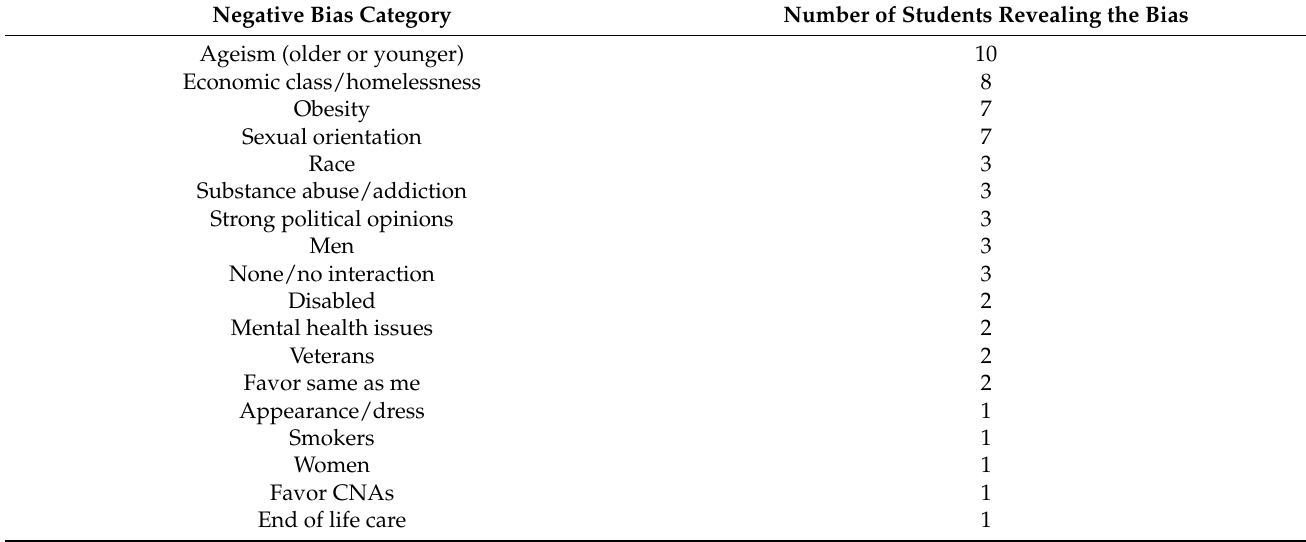
Table 2. Categories of student biases revealed by the question “Of what biases did you become aware during encounters with people/venues in your service-learning project?” (56 of 61 students expressed at least one